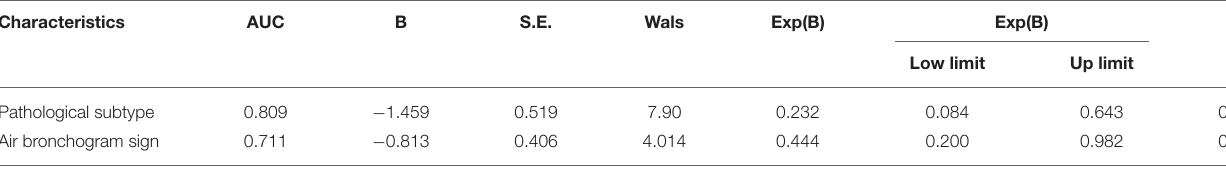
TABLE 5 | ROC curve of the main factors affecting the Ki-67 expression level. Characteristics